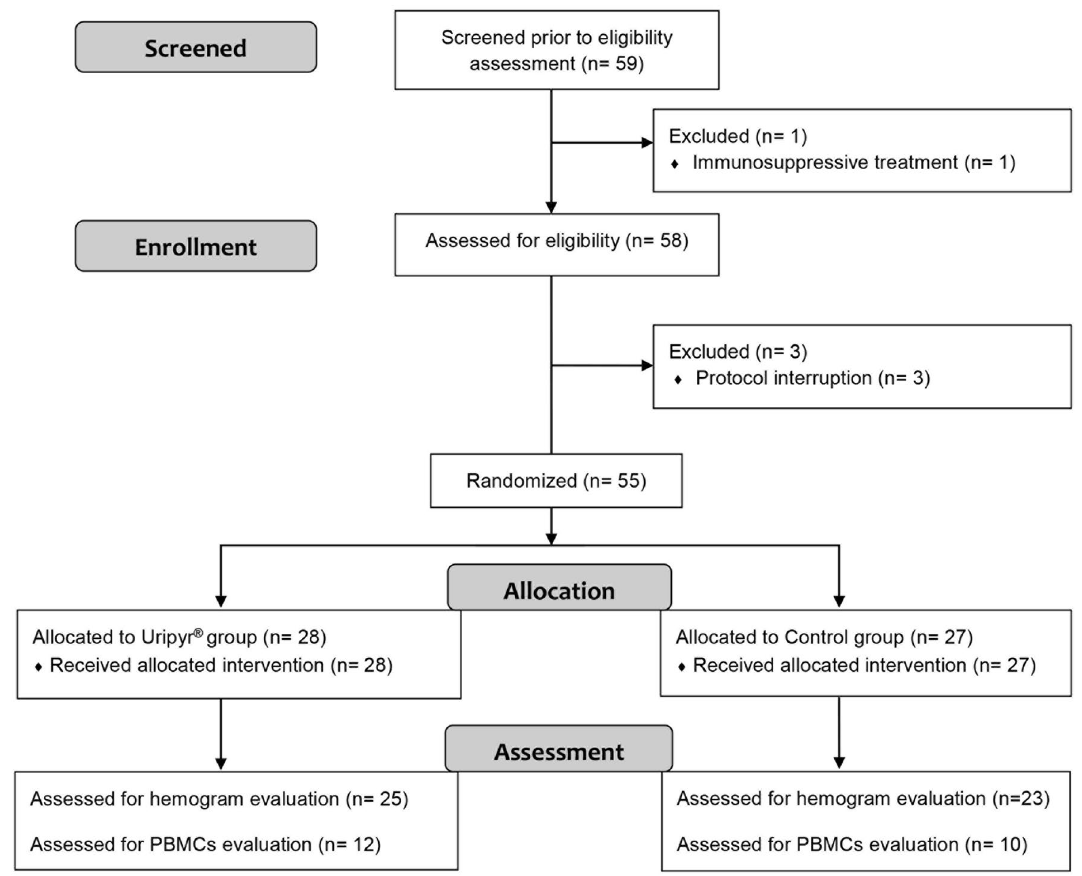
Figure 1. Flow chart for the selection of study